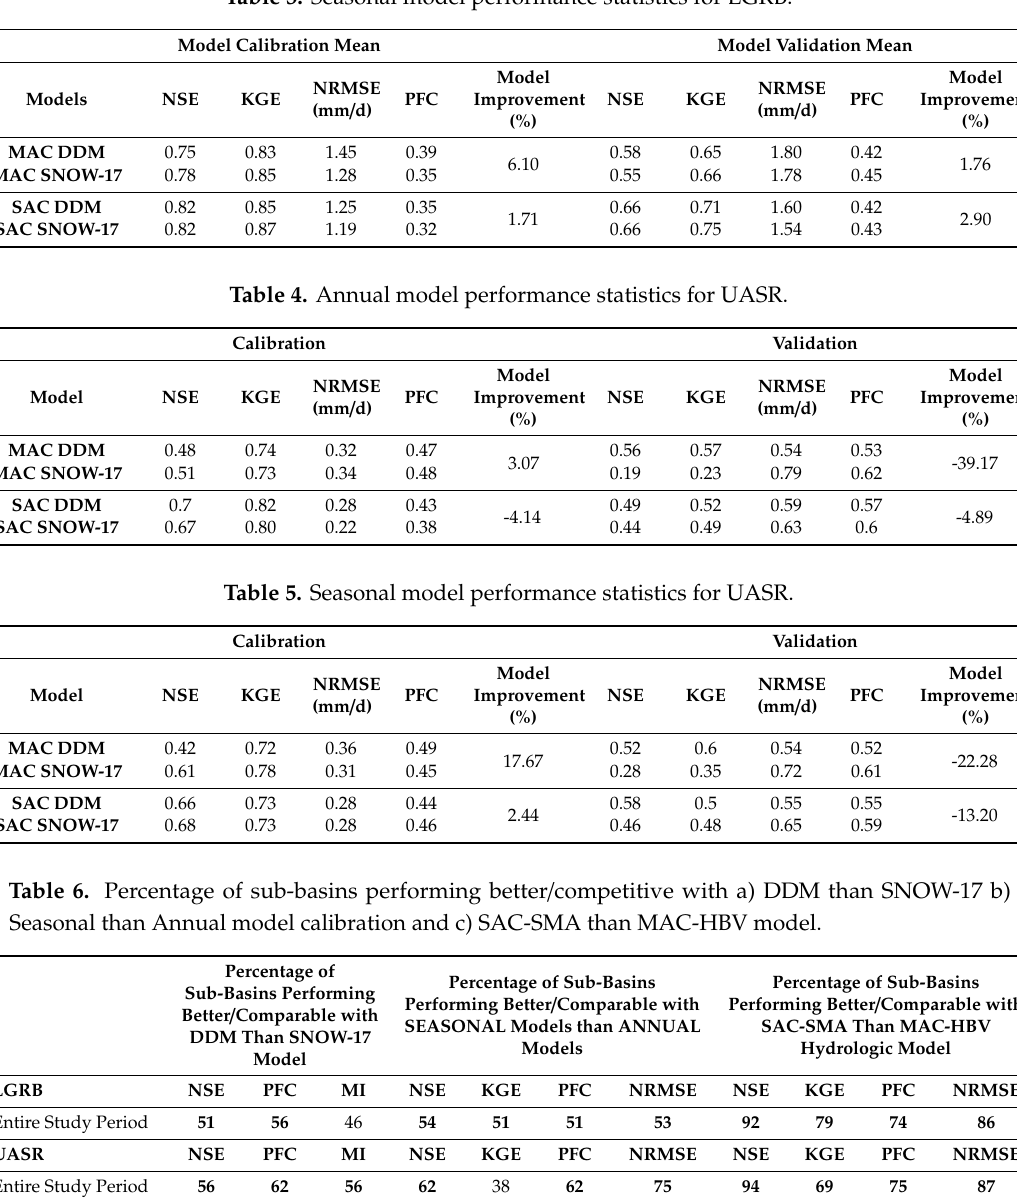
Table 3. Seasonal model performance statistics for LGRB.